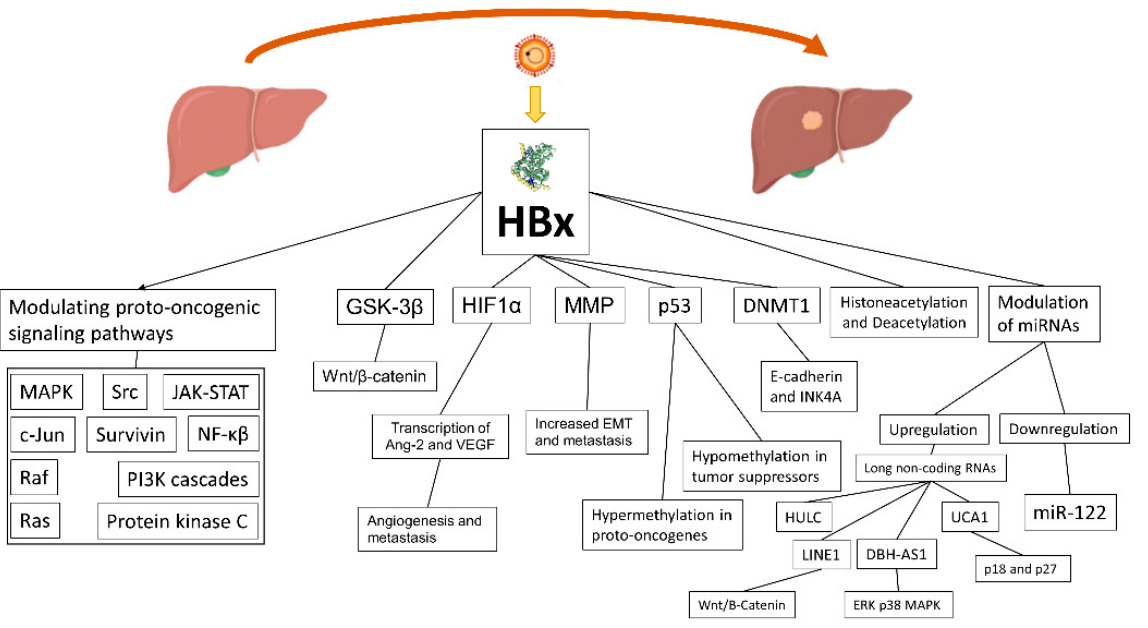
Figure 1. The role of HBx on HCC development in HBV-related HCC.